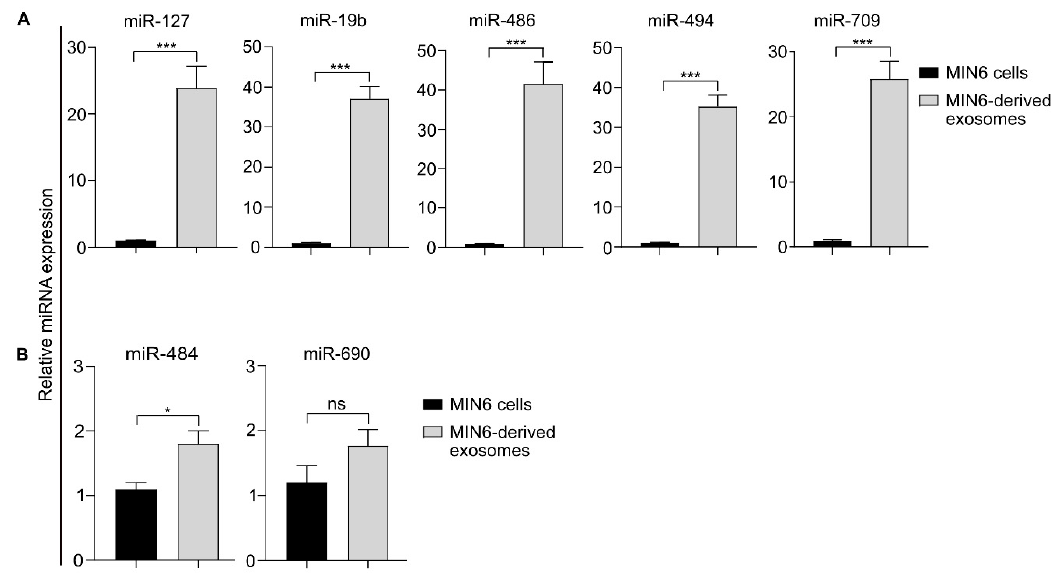
Figure 6. Relative expression of miRNAs inside exosomes and parent cells. The expression of ( A ) highly upregulated miRNAs (miR-127, mir-19b, miR-486, miR-494, and miR-709) is shown, and the expression of ( B ) non-moderated miRNAs (miR-484 and miR-690) is compared with that of the U6 snRNA control. Significant differences are indicated by * p < 0.05 and *** p < 0.001. Statistical analysis was performed using two-tailed, paired t -testing of three independent experiments. ns = non- significant.